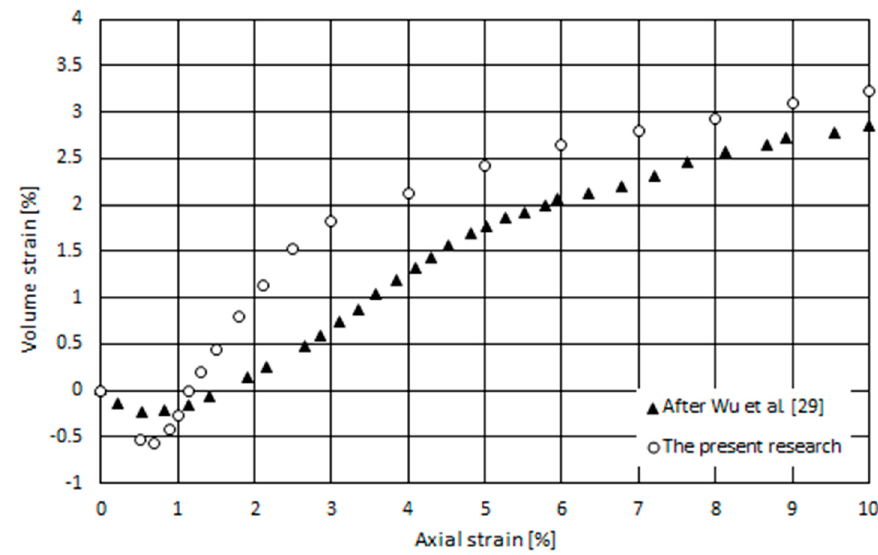
Figure 18. Compare the volumetric strain with axial strain.